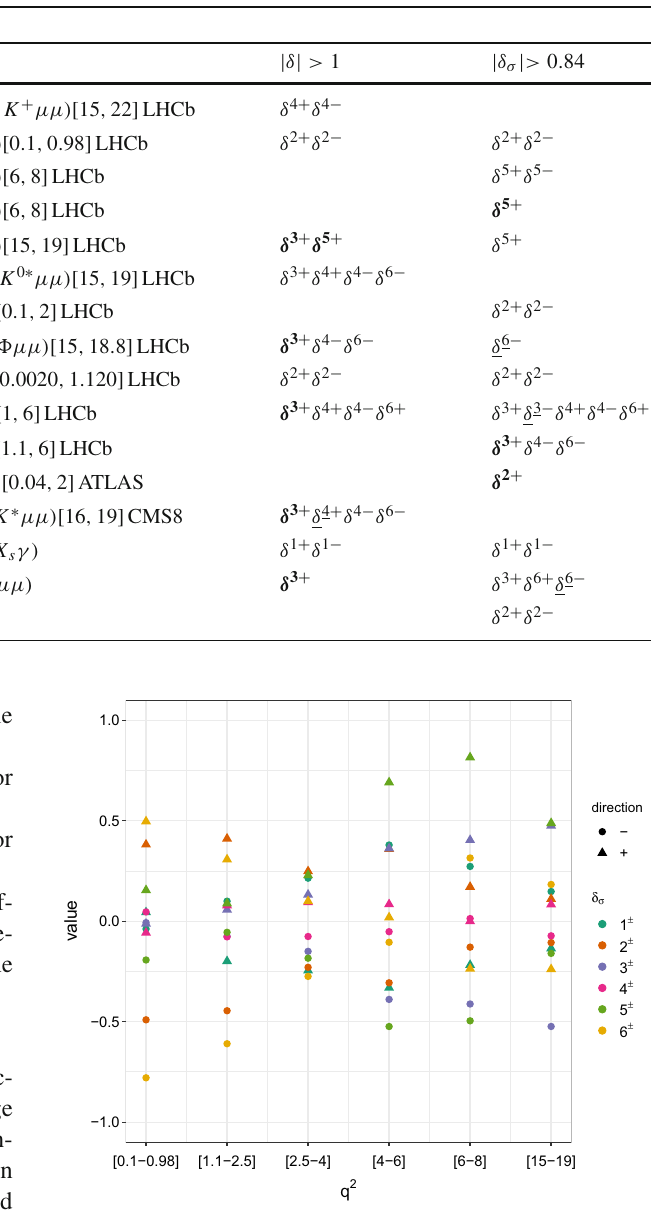
Fig. 7 Distribution of δ σ for the P (cid:3) q 2